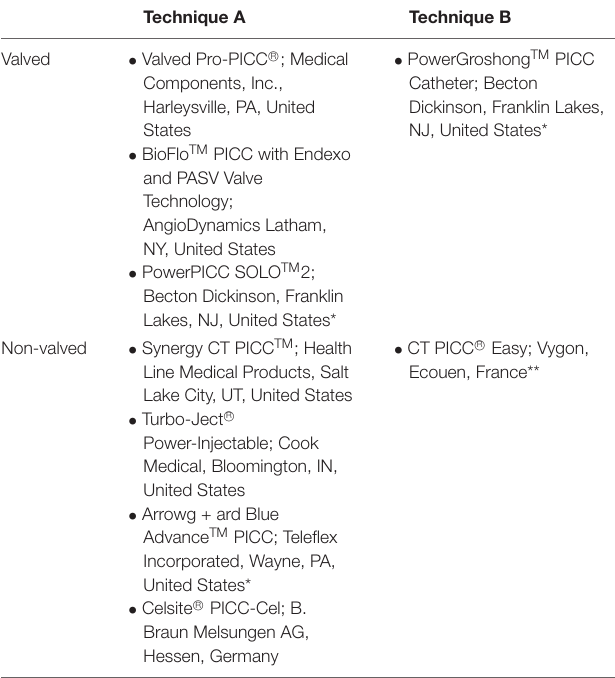
TABLE 2 | Summary of different commercially available PICC devices classified by technique and valve presence. Technique A Technique